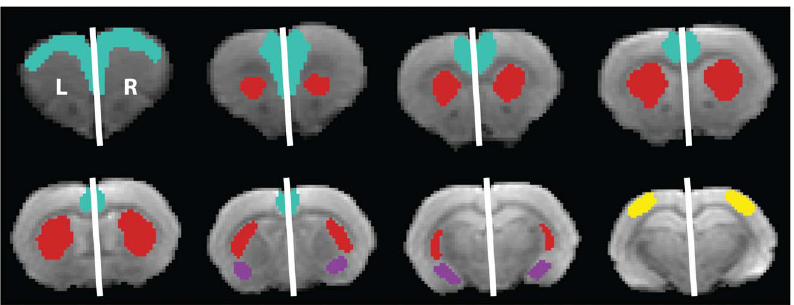
Figure 2. Regions of interest. The prefrontal cortex (blue), caudate putamen (red), amygdala (purple) and the somatosensory cortex (yellow) of the left (L) and the right (R) hemisphere were delineated on the B 0 images and the estimated diffusion parametric maps, referencing to a rat brain atlas [25].